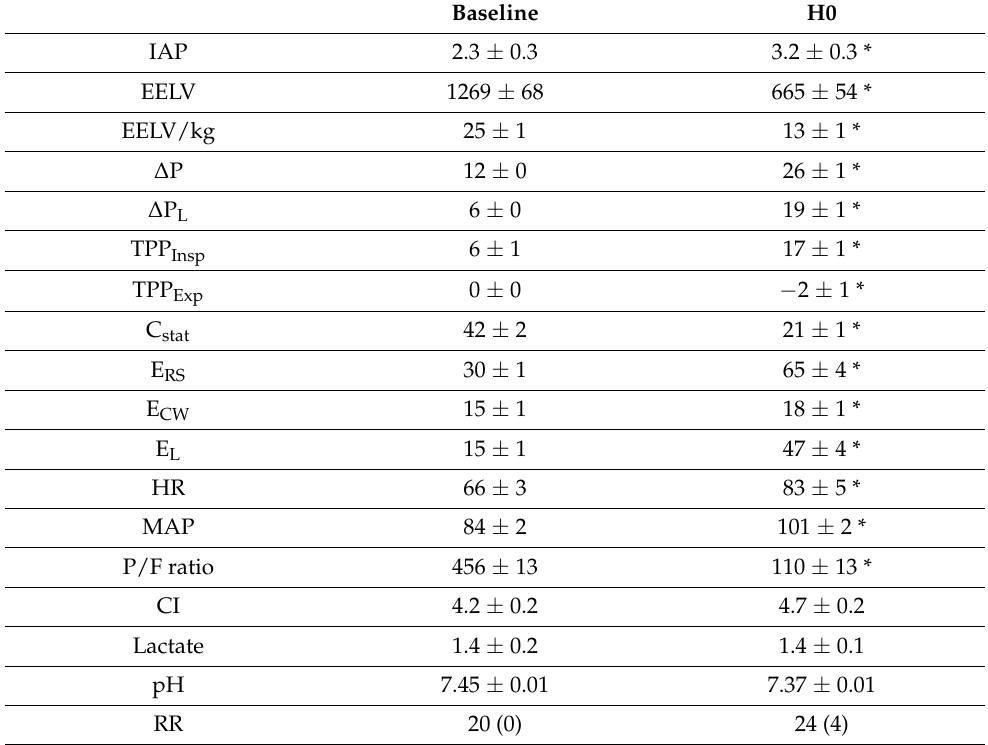
Table 1. Pulmonary and hemodynamic parameters after induction of acute lung injury at H0 compared with baseline